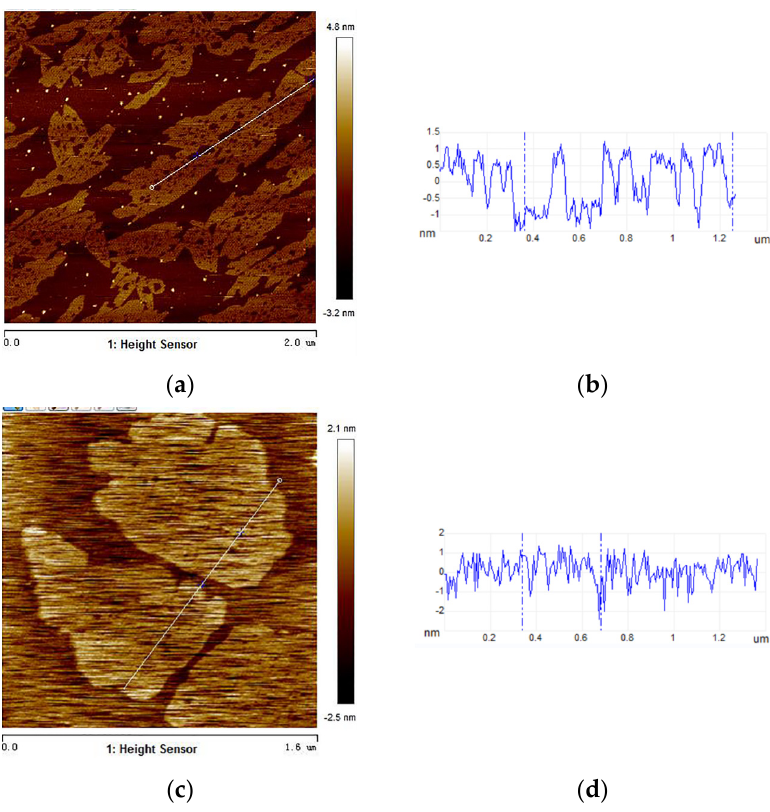
Figure 5. ( a , b ) AFM images and corresponding thickness of pure 2D g-C 3 N 4 and ( c , d ) 0.5 % Co 3 O 4 /g- C 3 N 4 .